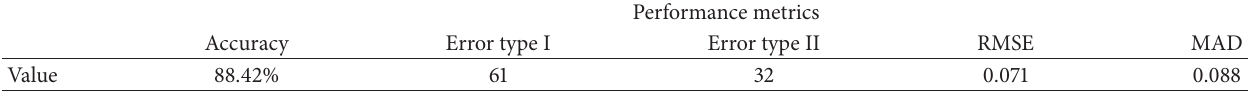
Table 4: Performance metrics of ANN + ANN + Cox hierarchical models.